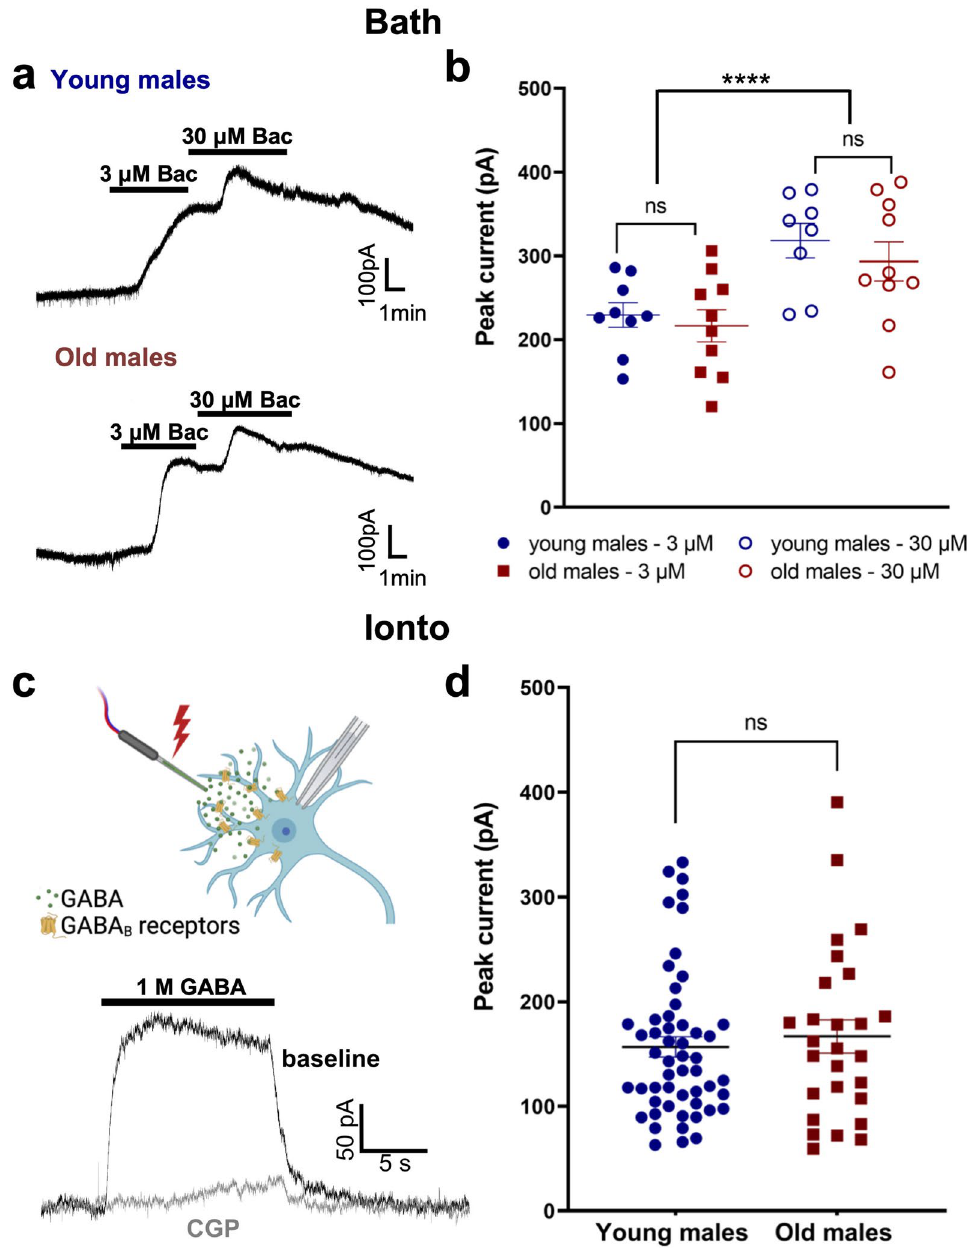
Figure 3. GABA B currents are similar in dopamine neurons from old and young male mice. ( a ) Representative traces of GABA B receptor-mediated currents in young (upper trace) and old (lower trace) males. Two concentrations of the GABA B agonist baclofen (3 and 30 µM) were applied sequentially to activate GIRK channels. ( b ) Maximum amplitudes for individual cells at each concentration showed no effect of age. ( c ) Schematic diagram of iontophoresis (top) and representative traces of GABA B receptor-mediated currents in the presence and absence of 100 nM of the GABA B receptor antagonist CGP 56999a (CGP; bottom). ( d ) Peak individual values of GABA B currents of individual cells. No differences were observed between groups. **** p < 0.0001. Diagram was created with